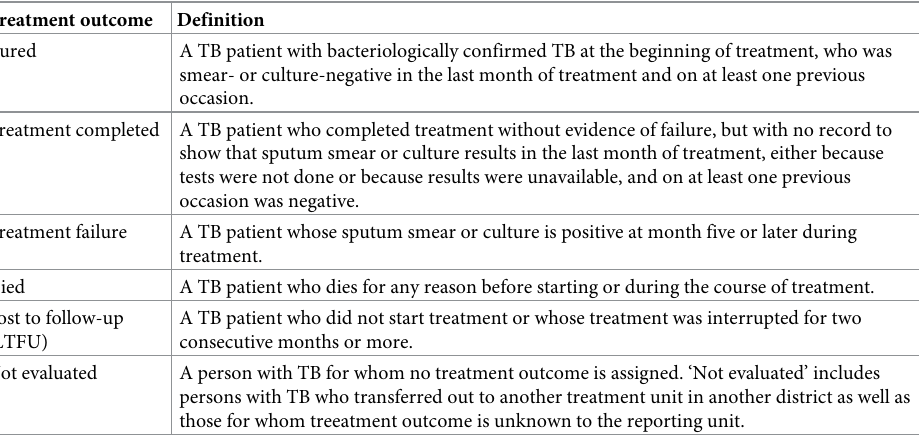
Table 1. Definition of treatment